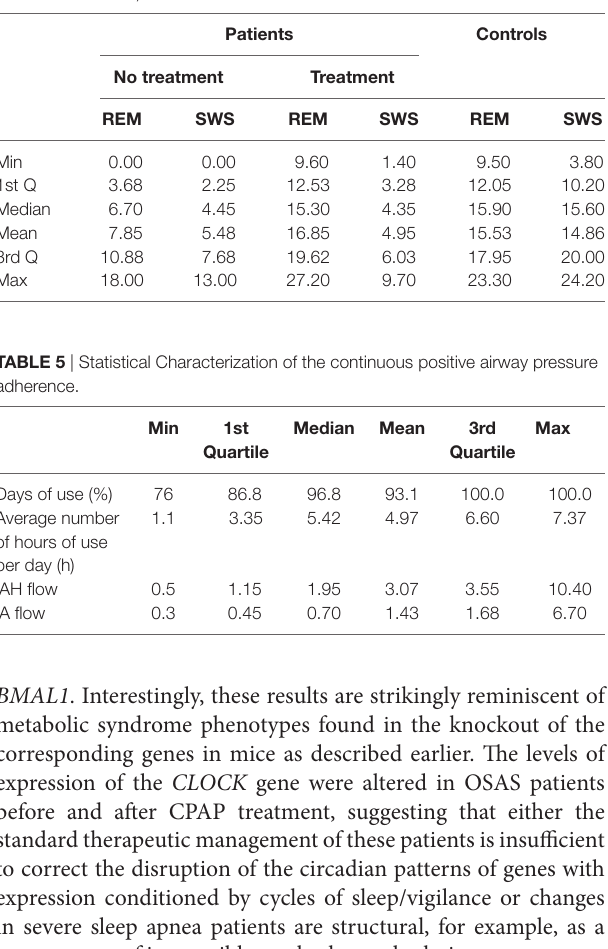
TaBle 4 | Slow wave sleep (SWS) and REM content, shown in percentage (%), in controls and patients (at diagnosis and after continuous positive airway pressure